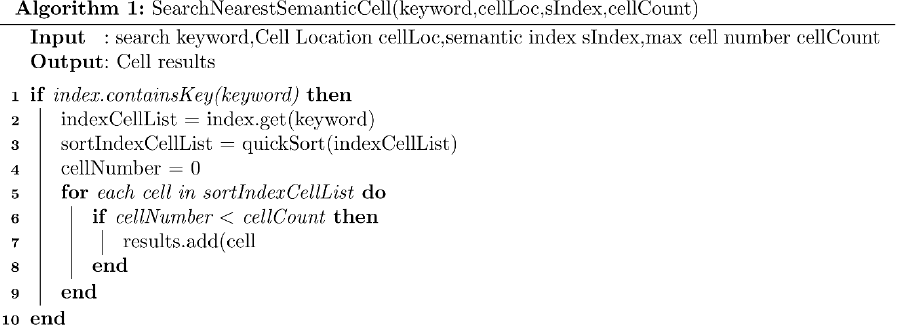
Figure 13. Semantic trajectory. The circle represents the moving object.